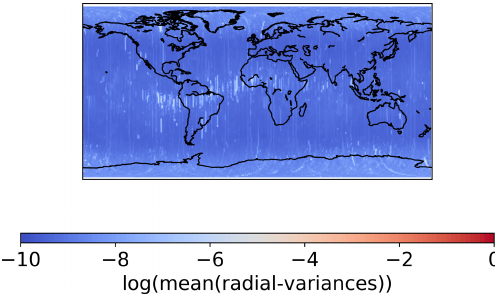
Figure 4. Radial variances binned for a longer time span in geo- graphic coordinates, November 2013–December